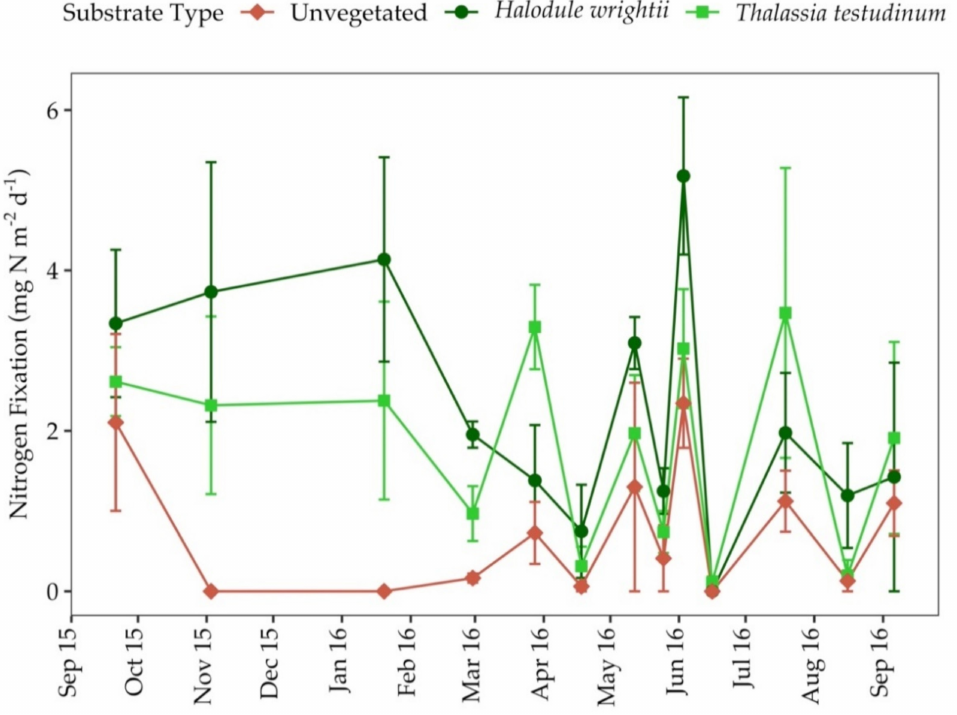
Figure 6. Nitrogen fixation rates in all substrate types from September 2015 to September 2016 at Big Sabine Point. Error bars represent the standard error of the